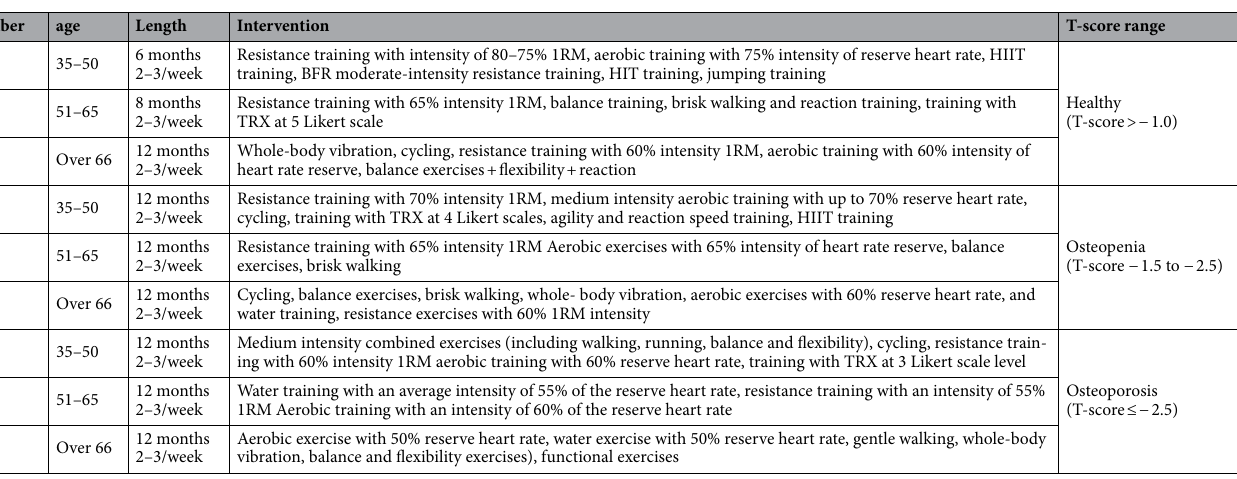
Table 5. Recommended exercises for men in three categories of healthy, osteopenia and OP. *Within the examined range, different classification algorithms were used. DT Decision tree, RF Random forest, KNN k-nearest neighbor, SVM Support vector machine, GB Gradient boosting, ET Extra trees, AB Ada Boost, ANN- MLP Artificial neural network multilayer